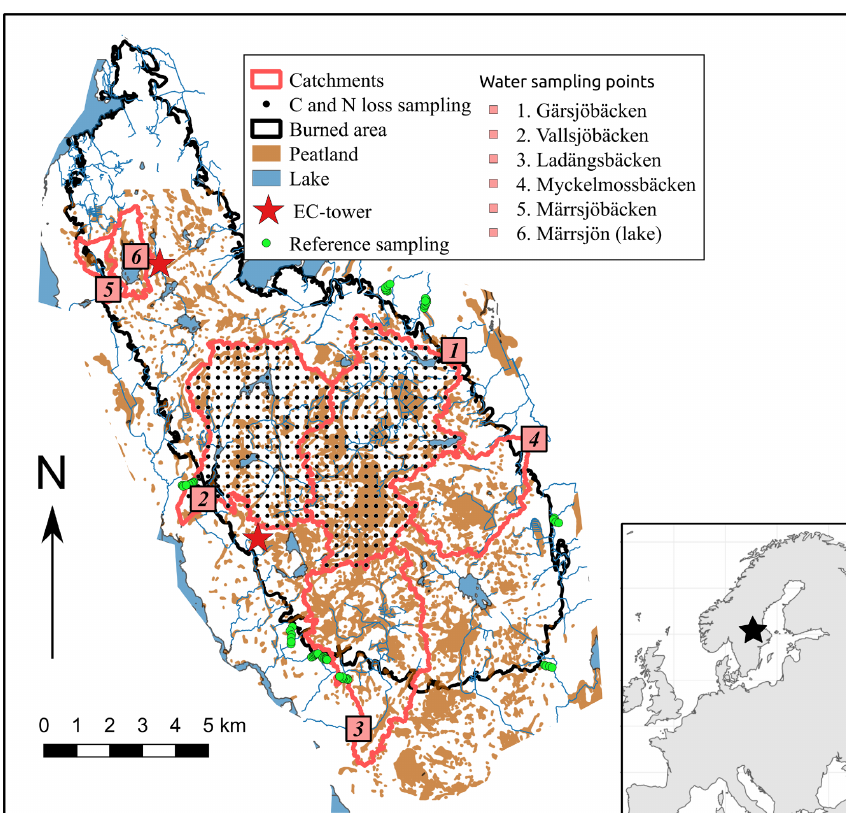
Figure 1. Map over the burned area showing the sampled catchments, sampling points (terrestrial C and N loss and reference plots, as well as water sampling stations), and placement of the eddy-covariance towers. Most of the burned, non-peatland areas of the catchments Ladängsbäcken, Myckelmossbäcken, and Märrsjöbäcken/Märrsjön were salvage logged. Table 1 contains information about the